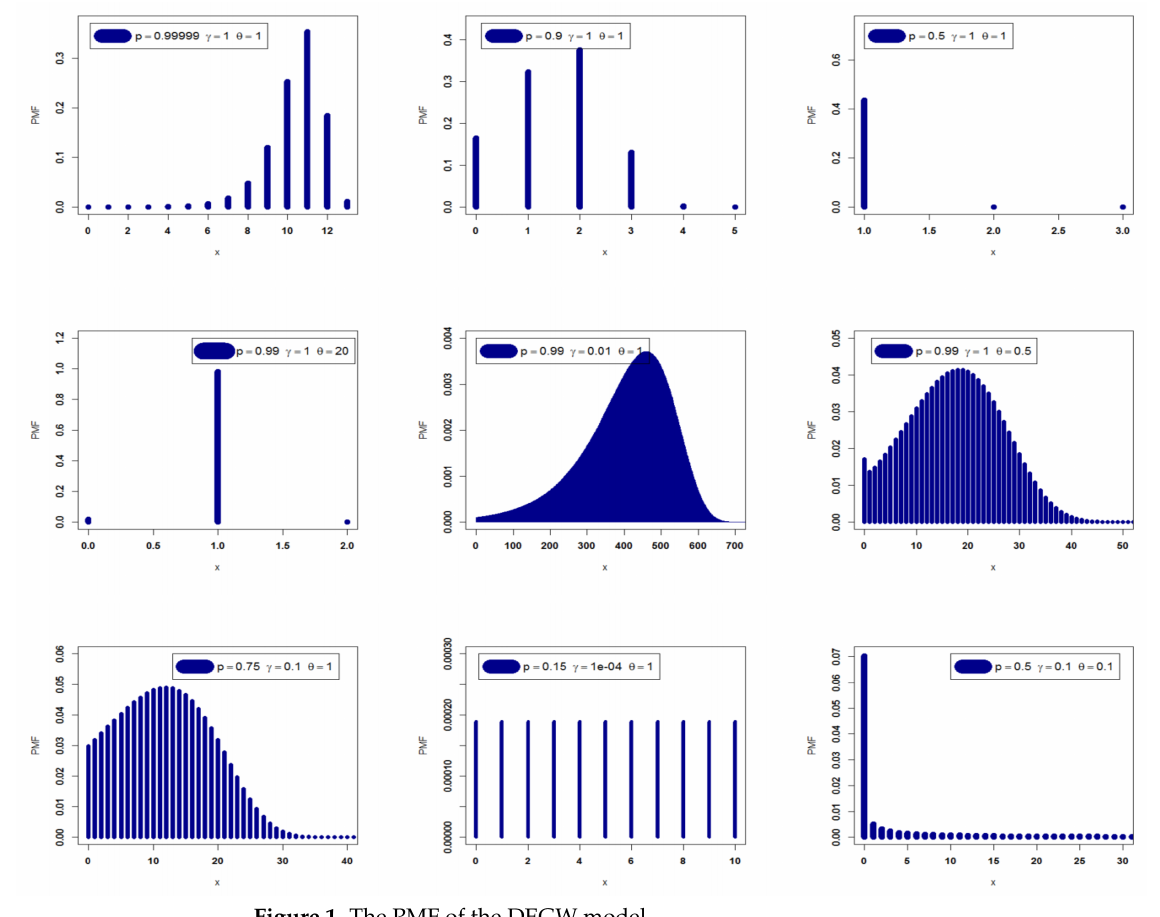
Figure 1. The PMF of the DEGW model.